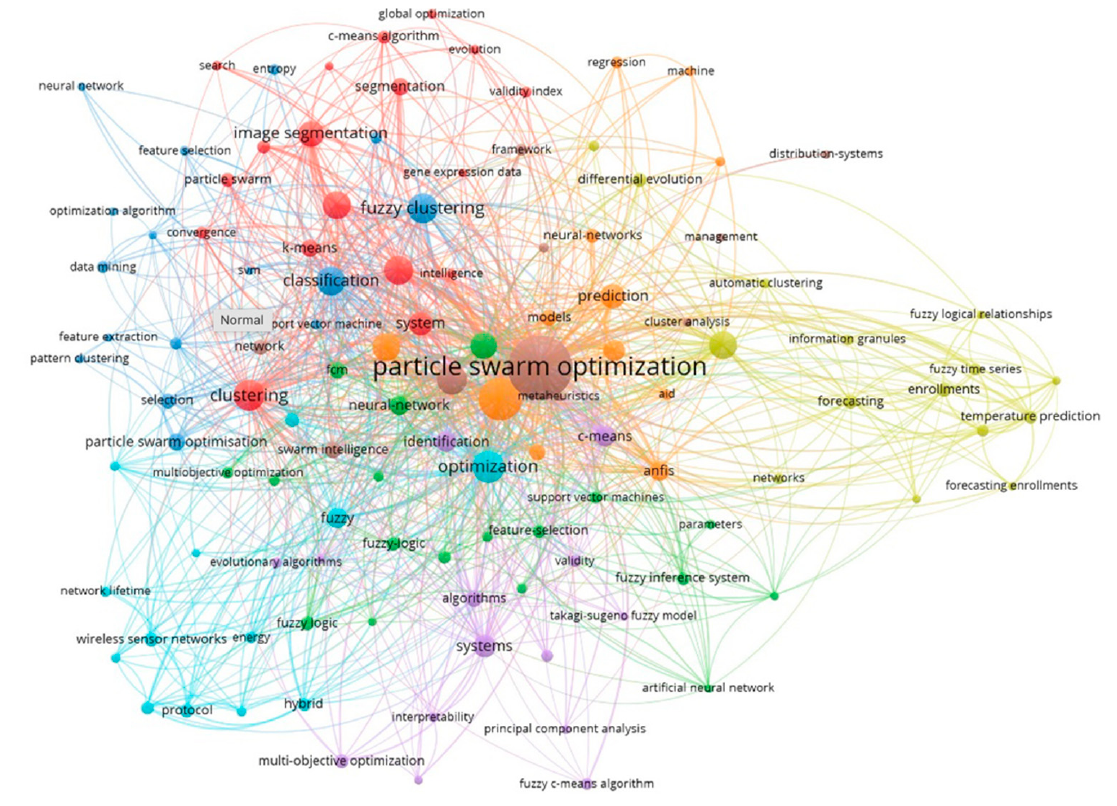
Figure 9. Total clustering obtained with the search “optimization fuzzy clustering with particle swarm optimization” from VOSviewer.